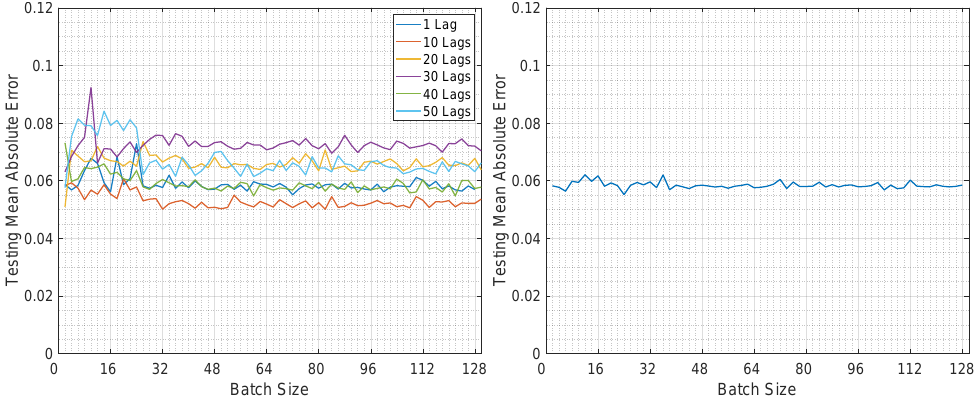
Figure 9. Illustration of the testing mean absolute error value for Experiment 2, LSTMTF ( left ) and VLSTM ( right ), using a many-to-one prediction